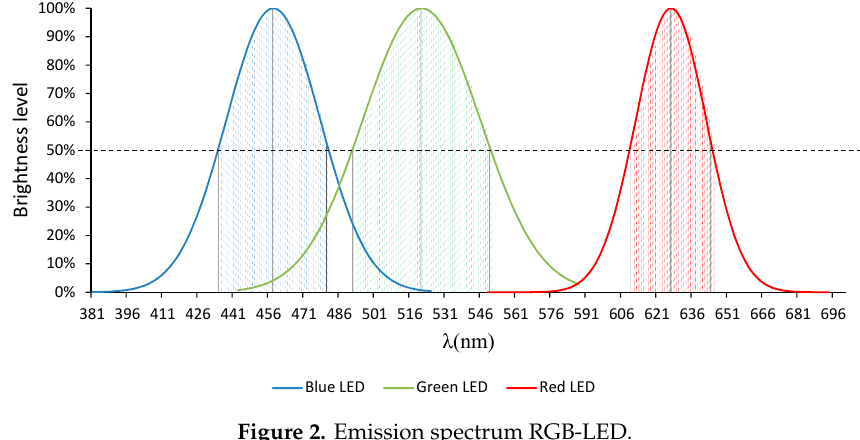
Figure 2. Emission spectrum RGB-LED.